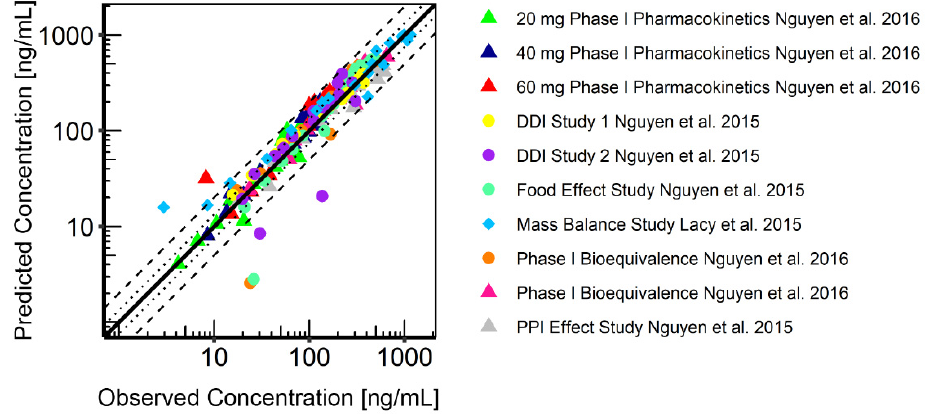
Figure 5. Goodness-of-fit plot showing predicted (geometric mean) versus observed CAB plasma concentrations. Tablet formulations are represented by triangles, capsule formulations are represented by dots, the solution is represented by diamonds. The black solid line represents the line of identity; dashed black lines represent a twofold deviation; dotted black lines represent a 1.25-fold deviation.